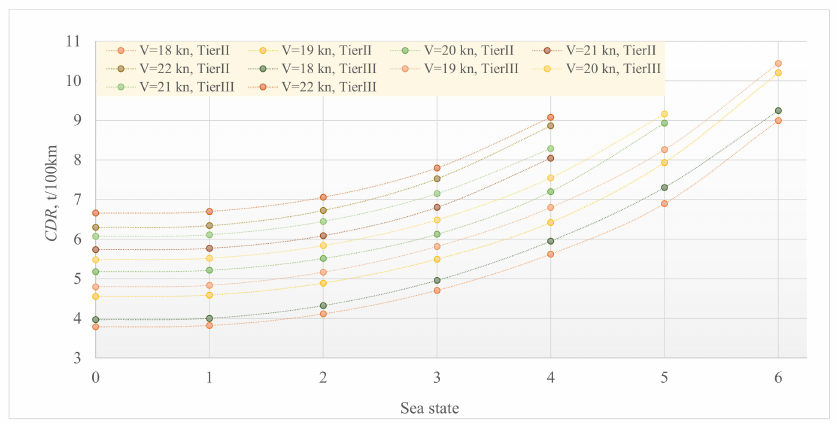
Figure 16. CO 2 emission reduction for NG fueling mode compared to FO mode for the same sailing speeds and sea states (Tier II and Tier